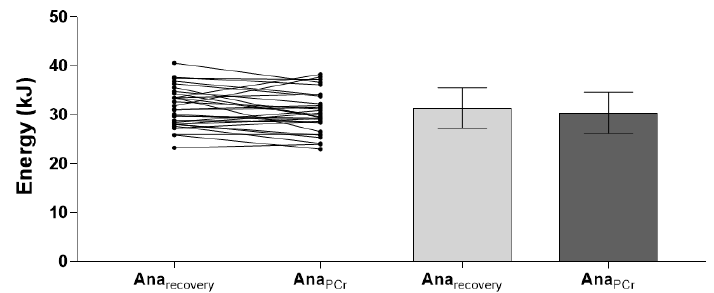
Figure 2. Individual and mean ± SD values of the VO 2 off-kinetics fast component and the maximal phosphocreatine splitting in the contracting muscle (Ana recovery and Ana PCr , respectively) methods for anaerobic alactic assessment.